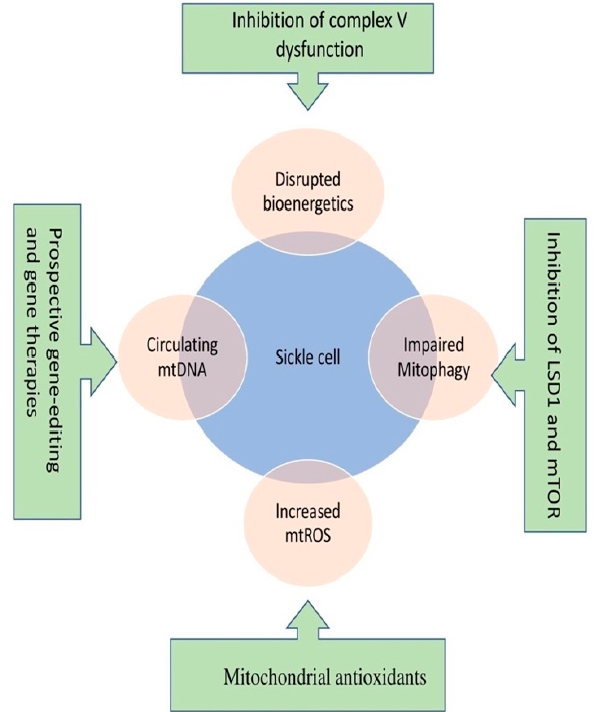
Figure 2. An all-inclusive approach to modulate bioenergetics, dynamics, and genome of mitochon- dria is of therapeutic importance in improving the treatment outcome in SCD.